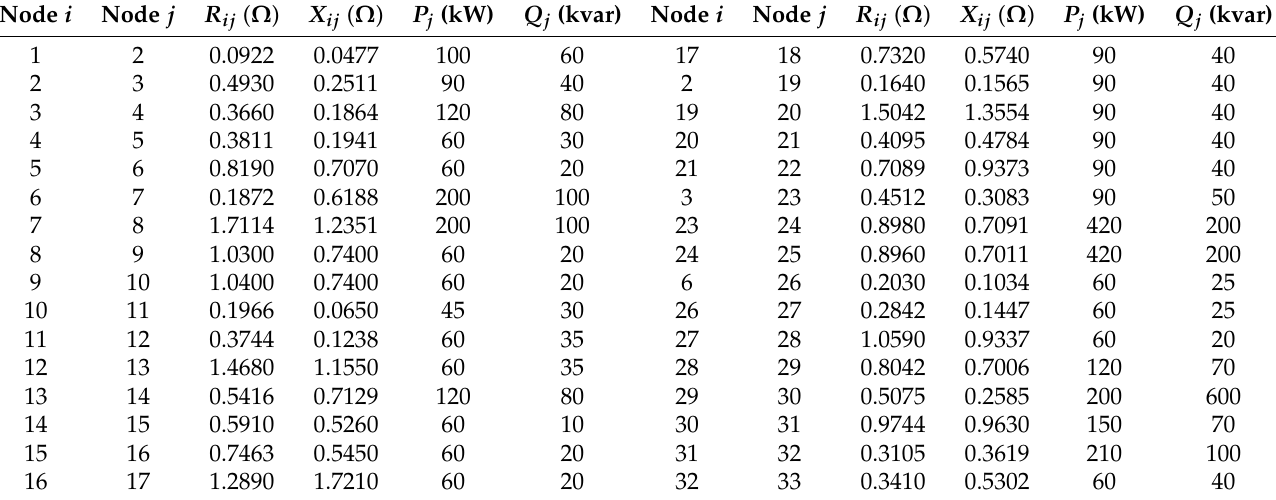
Figure 2. Distribution grids under study: ( a ) IEEE 33-bus system and ( b ) IEEE 69-bus system. The main characteristic of these test feeders is that both operate at the substation bus with an output voltage of 12.66 kV. The electrical parameters for these grids are reported in Tables 1 and 2, respectively. Table 1. Branch and load parameters of the IEEE 33-bus